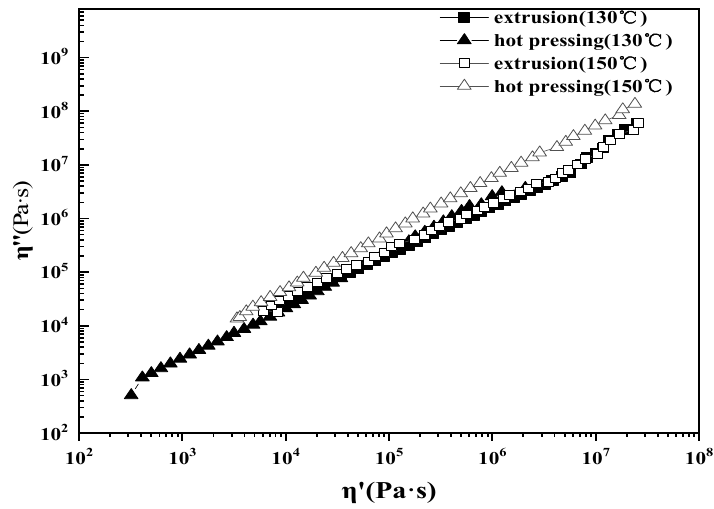
Figure 11. Loss viscosity of straw / LLDPE composite as a function of storage viscosity.